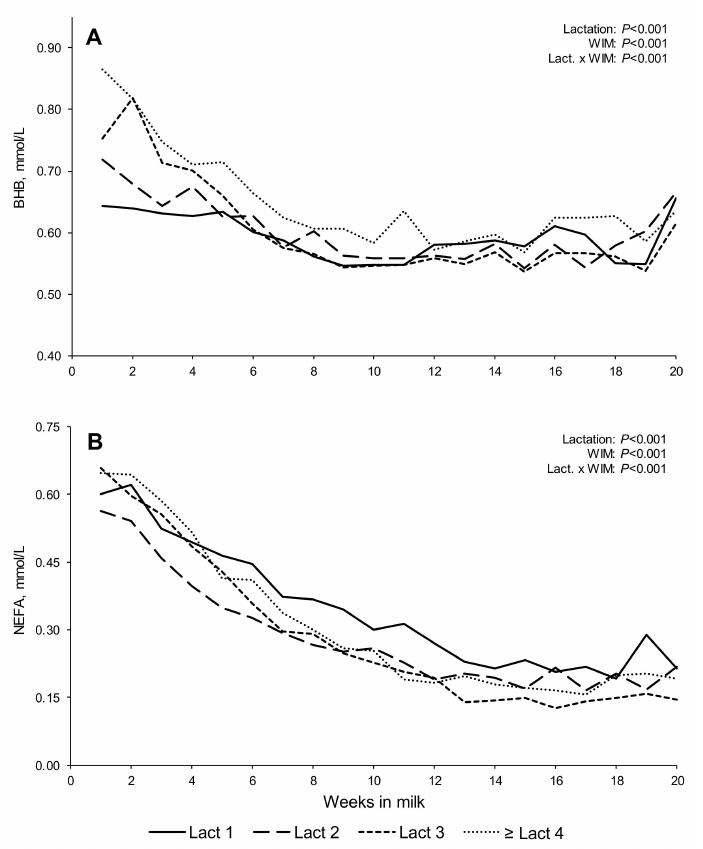
Figure 4. Least squares means, adjusted by the random crossed effects of study and cow, for blood metabolites—beta-hydroxybutyrate (BHB; ( A )), and non-esterified fatty acids (NEFA; ( B ))—in early lactation dairy cows (1–20 WIM).